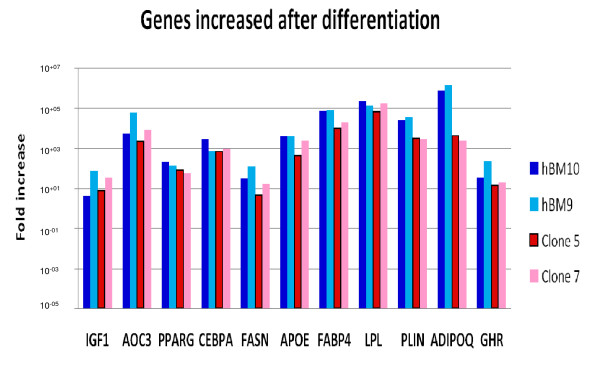
Quantitative RT- PCR-analysis. RNA from primary layers and clones was extracted before differentiation induction (day 0) and 14 days after addition of the adipogenic media. Here we tested the discussed adipogenic marker genes IGF 1, AOC3, PPARG, CEBPA, FASN, APOPE, FABP4, LPL, PLIN, ADIPOQ and GHR for up-regulated expression using quantitative RT-PCR-technology. For gene names see Additional file 1.